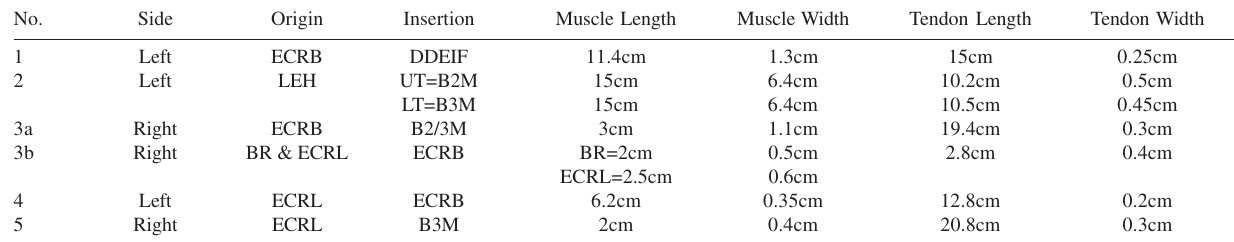
Table 1 - Origin, insertion and measurements of the additional radial wrist extensors (ARWEs). No.